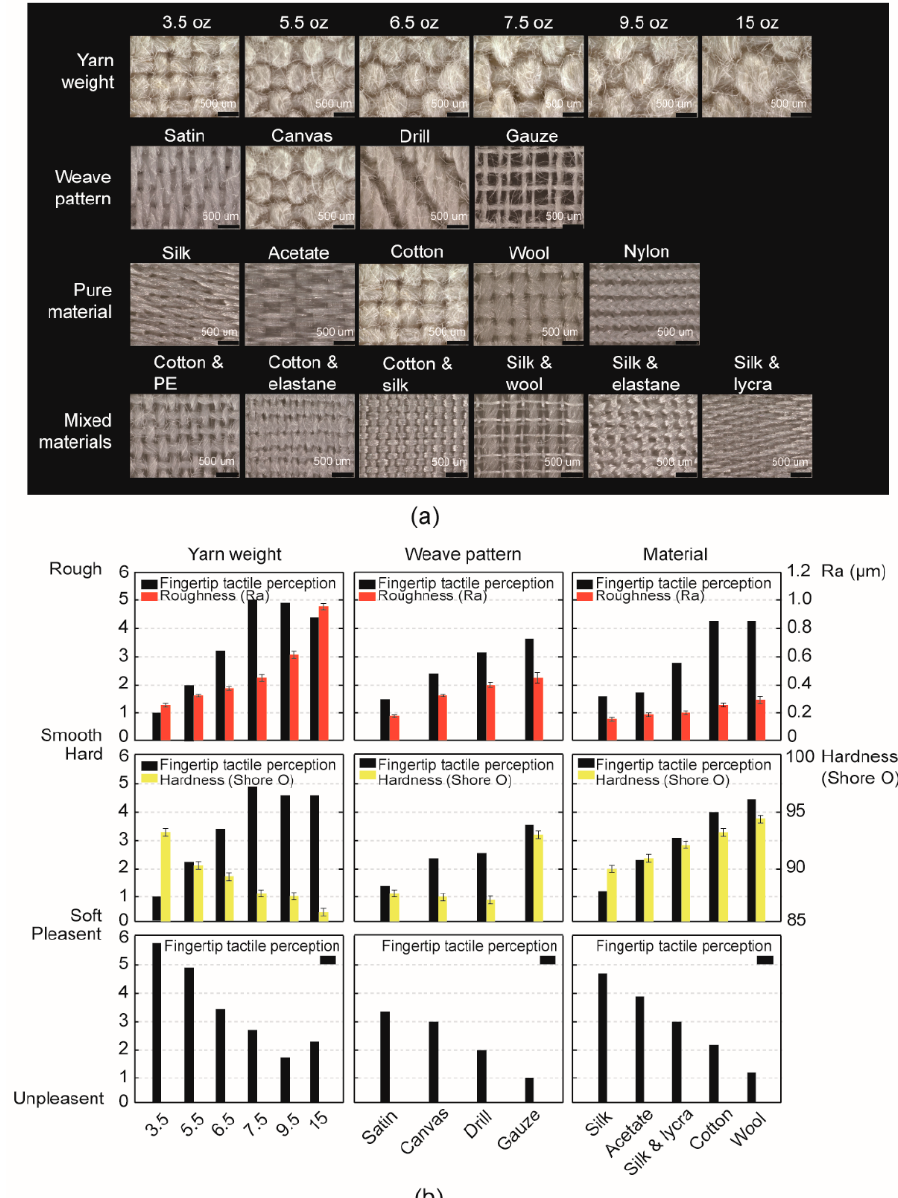
Figure 2. ( a ) A schematic overview of the stimuli from three groups of commercial textile fabrics used in the experiments. In the top, cotton fabrics with six different yarn weights from 3.5 to 15 oz/yd 2 are shown. Then four different weave structures followed with five pure-material and six mixed-material fabrics are shown in the following panel. ( b ) Results for the yarn weight, weave pattern, and material tactile perception on rough/smooth, hard/soft, and pleasant/unpleasant. The black chart represents the mean estimation of human fingertip tactile perception. Other color charts illustrate the material properties as shown in the Tables 1 and 2.